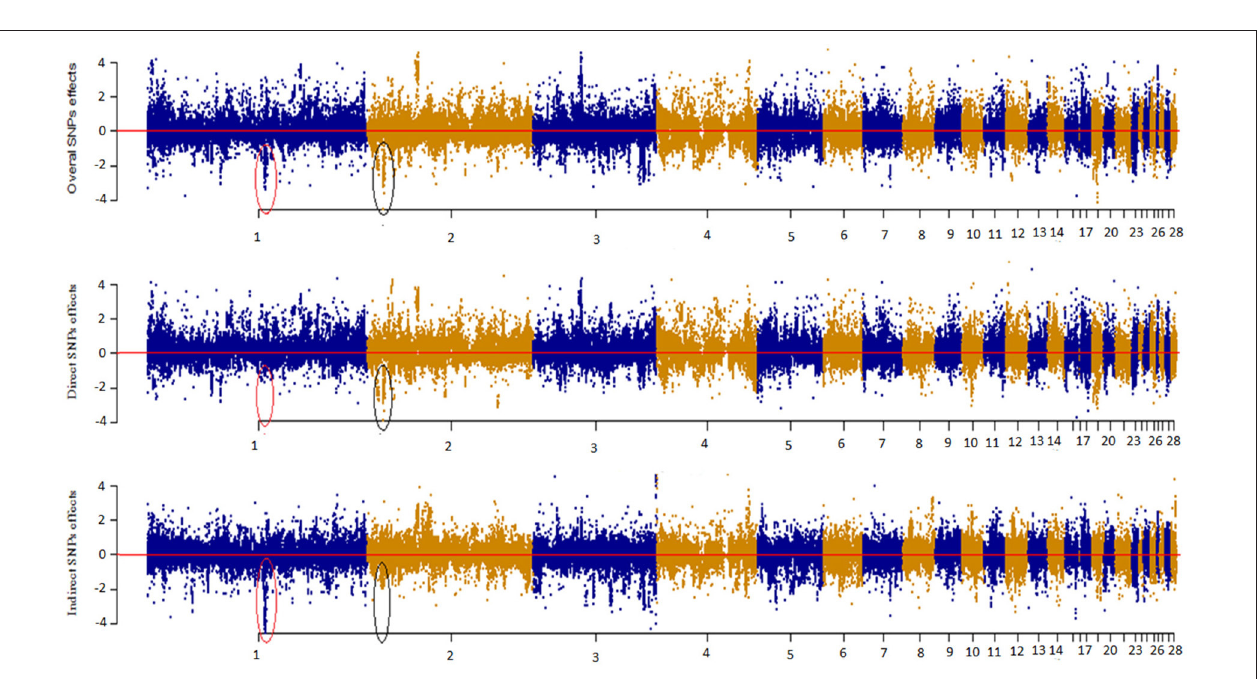
diverse chicken populations (Sun et al., 2013; Van